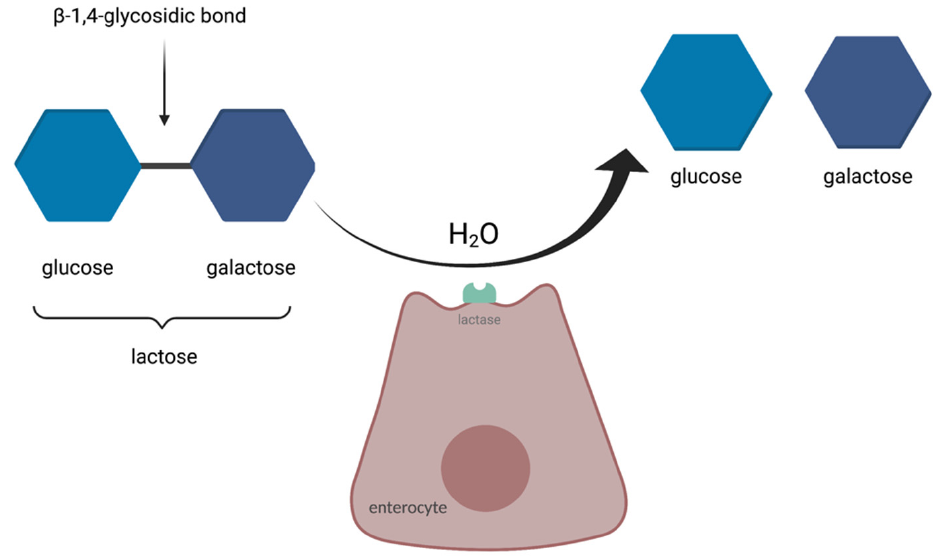
Figure 1. The enzymatic breakdown of lactose, based on [9]. Lactose malabsorption can be categorized into four groups, according to the World Allergy Organization (WAO):